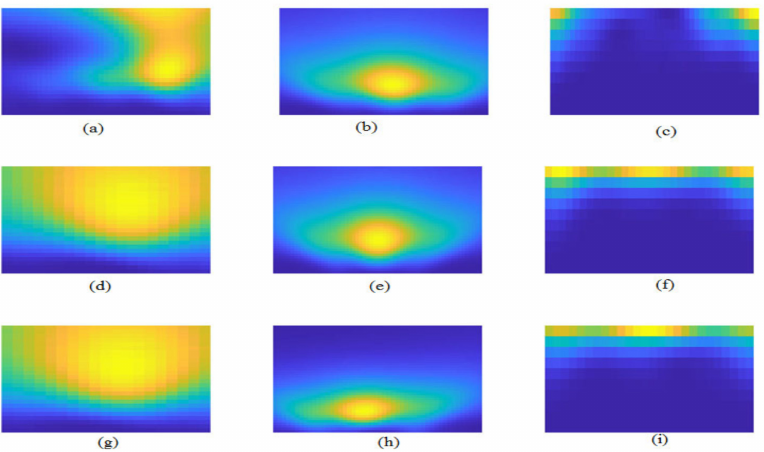
Figure 9. The Scalogram for ECG types: ( a ) The Normal P-wave SG; ( b ) The Normal QRS-waves SG; ( c ) The Normal T-wave SG; ( d ) The Bradycardia P-wave SG; ( e ) The Bradycardia QRS-waves SG; ( f ) The Bradycardia T-wave SG; ( g ) The Tachycardia P-wave SG; ( h ) The Tachycardia QRS-waves SG; ( i ) The Tachycardia T-wave